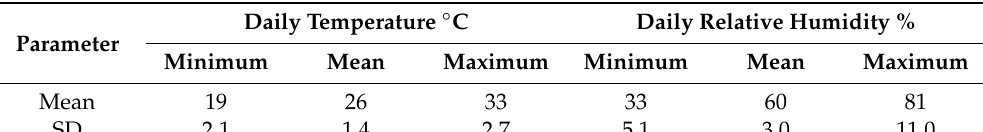
Table 2. Average daily temperature and relative humidity with minimum and maximum values and SD for Experiment 1.